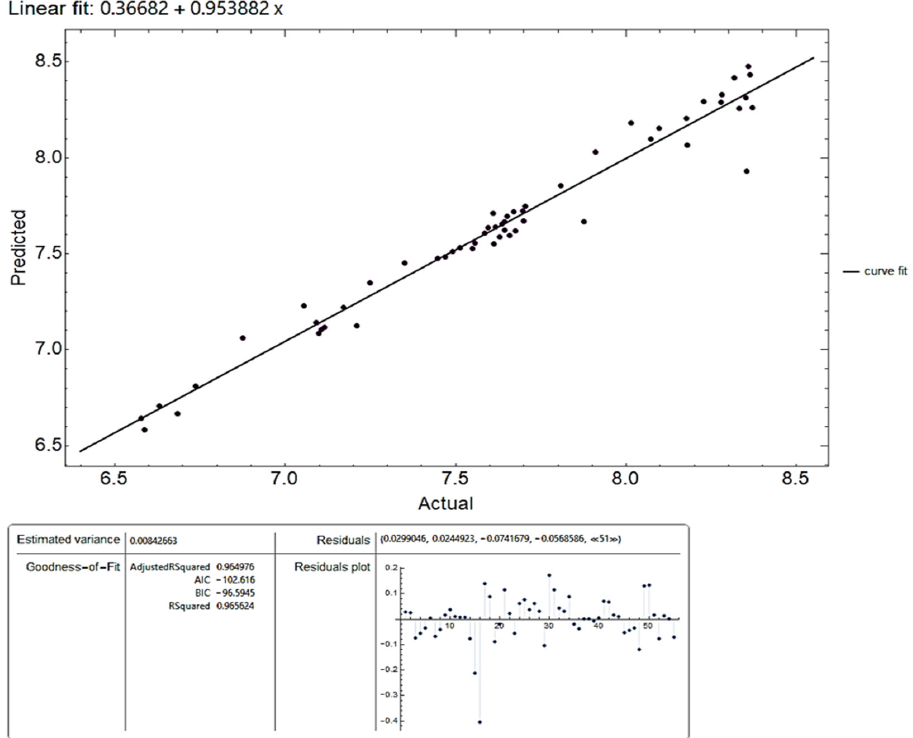
Figure 5. Predicted values of daily cash balances in the 2019 federal budget TSA against the actual values after the first iteration based on the DW [3] transformation (R2~0.9656), in trillion rubles. Source: authors’ calculations.